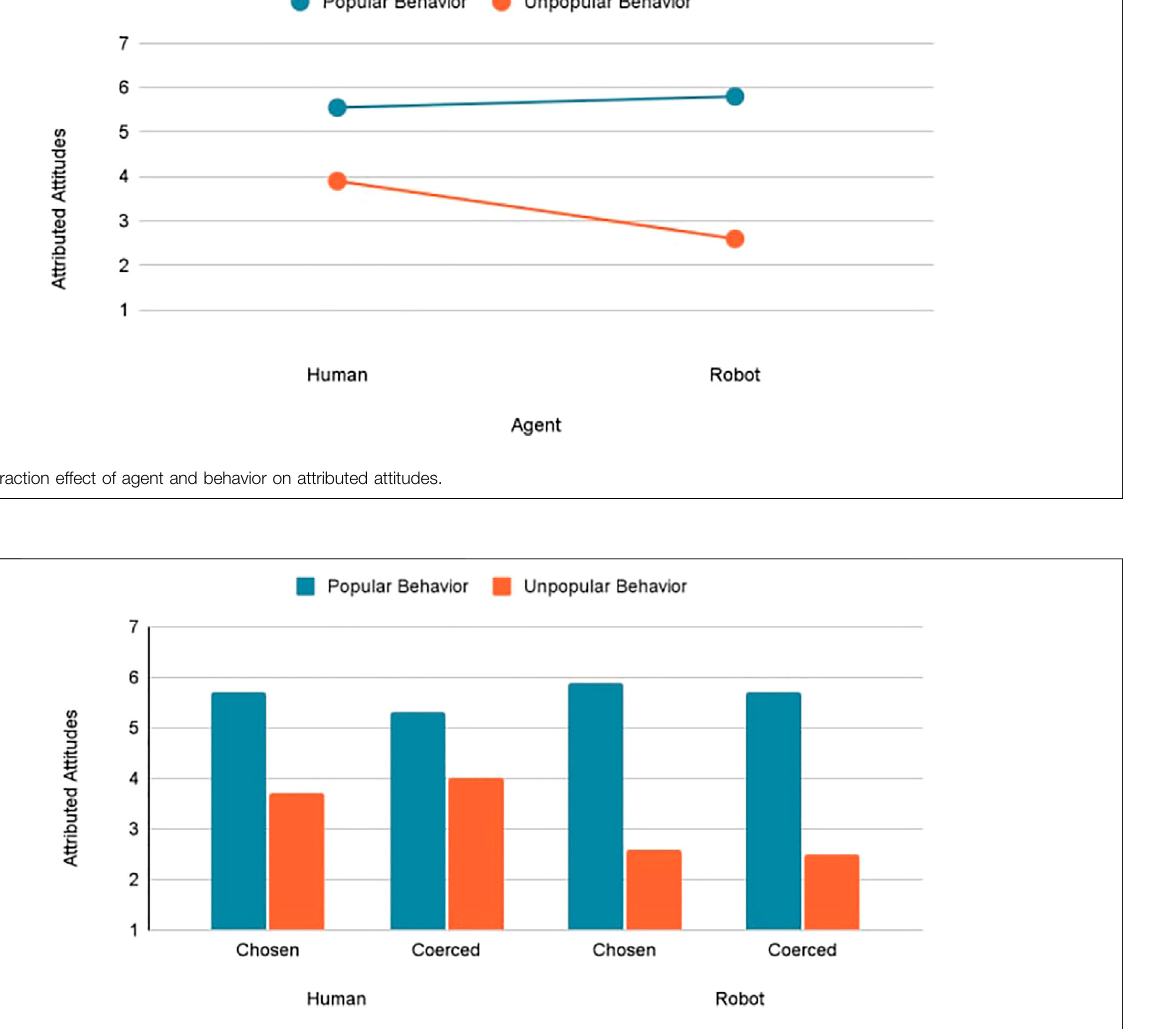
Frontiers in Robotics and AI |